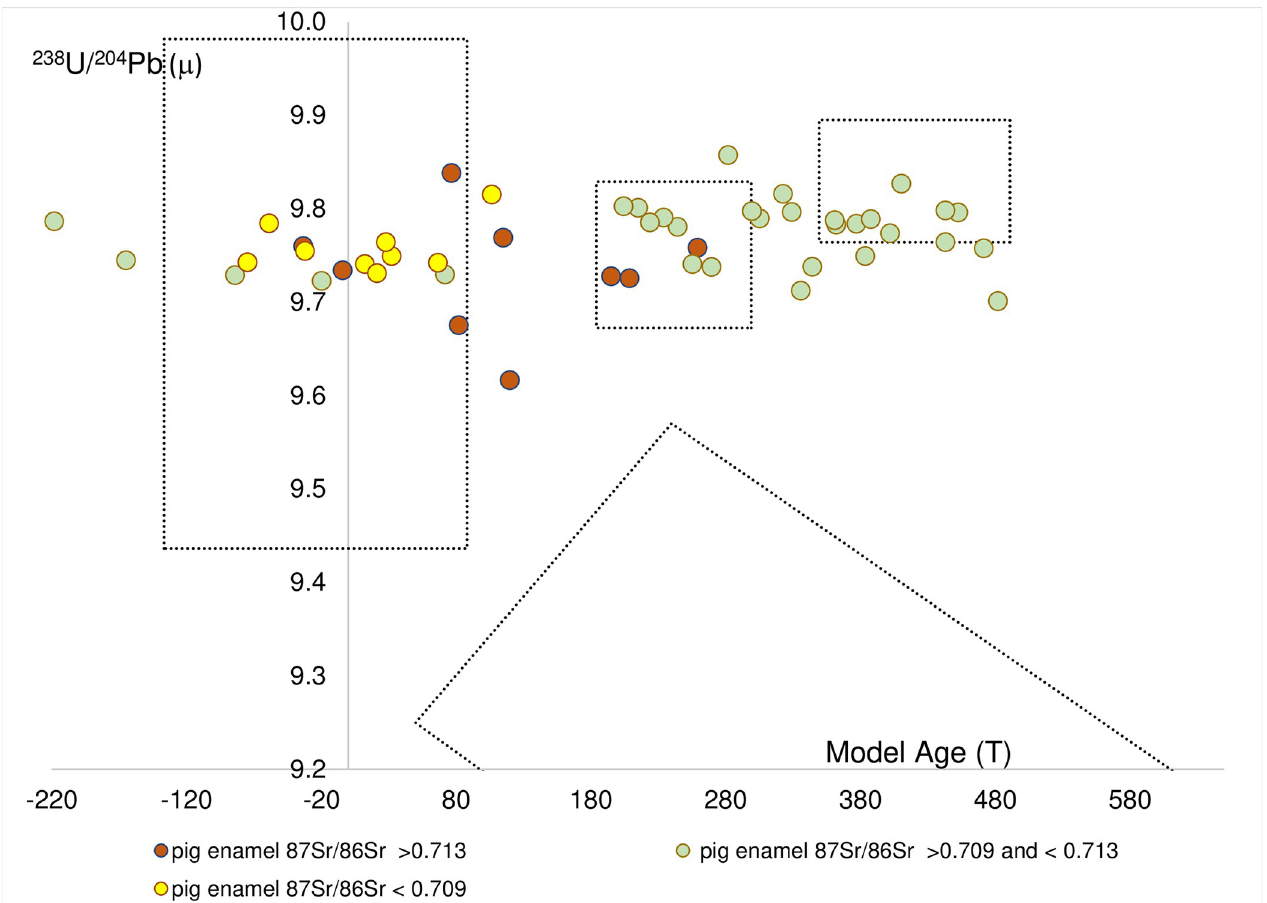
Fig 4. The pig tooth enamel from the henges shown in relationship to the mineral reference fields. The data are colour-coded based on strontium isotope ranges of the enamel.